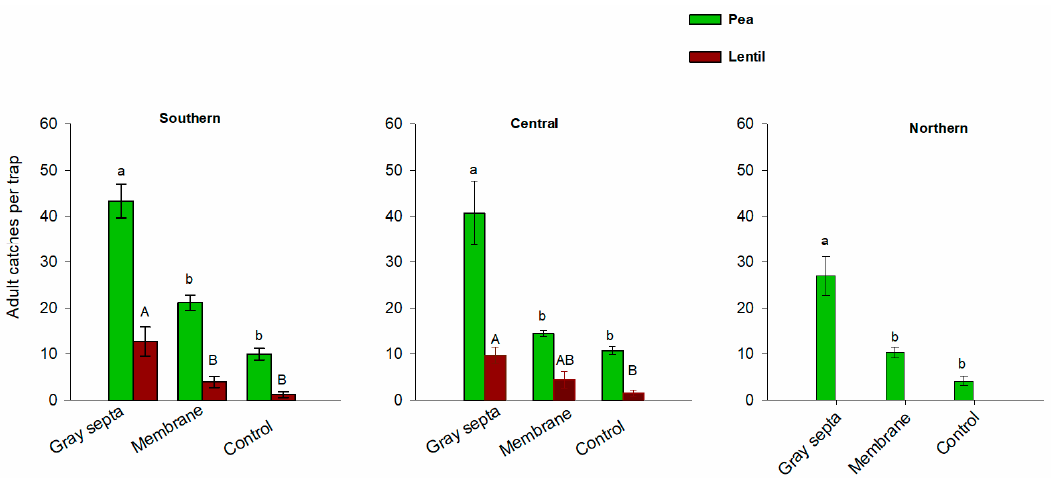
Figure 5. Mean total captures per pitfall trap ± S.E. of Sitona lineatus adults in pea and lentil fields at southern, central and northern clusters of the Golden Triangle, Montana, from the first week of April to the end of July, 2016. Mean values within bars bearing the same upper-case or lower-case letters in each cluster are not significantly different (Mann–Whitney U -tests followed by Bonferroni correction [ α = 0.01]).